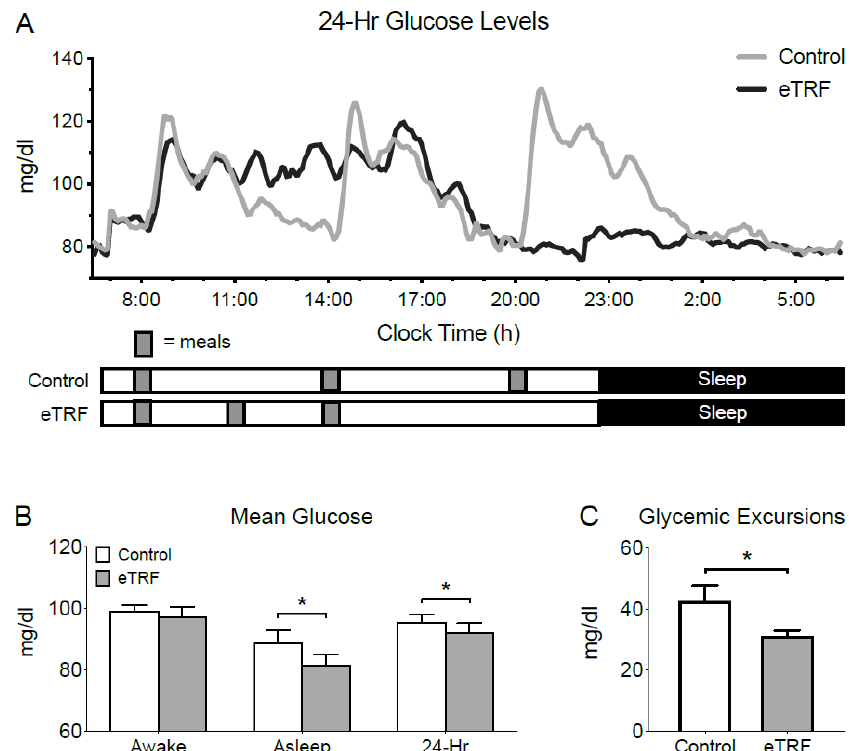
Figure 2. 24-Hour Glucose Levels. Relative to the control schedule, early time-restricted feeding (eTRF) ( A ) changed the temporal profile of 24-hour glucose levels, as measured by continuous glucose monitoring, particularly in the evening, ( B ) lowered mean glucose levels while asleep and decreased 24-hour mean glucose levels, and ( C ) lowered glycemic excursions as measured by Mean Amplitude of Glycemic Excursions (MAGE). Error bars on panel ( A ) are suppressed for visual clarity. * p < 0.05. Nutrients 2019 , 11 , x FOR PEER REVIEW